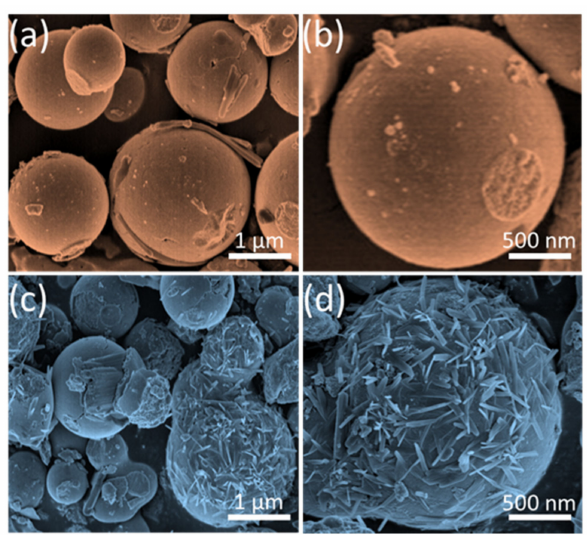
Figure 3. ( a , b )SEMmicrographsofthepristineNiO.( c , d )SEMmicrographsoftheSnO 2 / NiOnanocomposite.